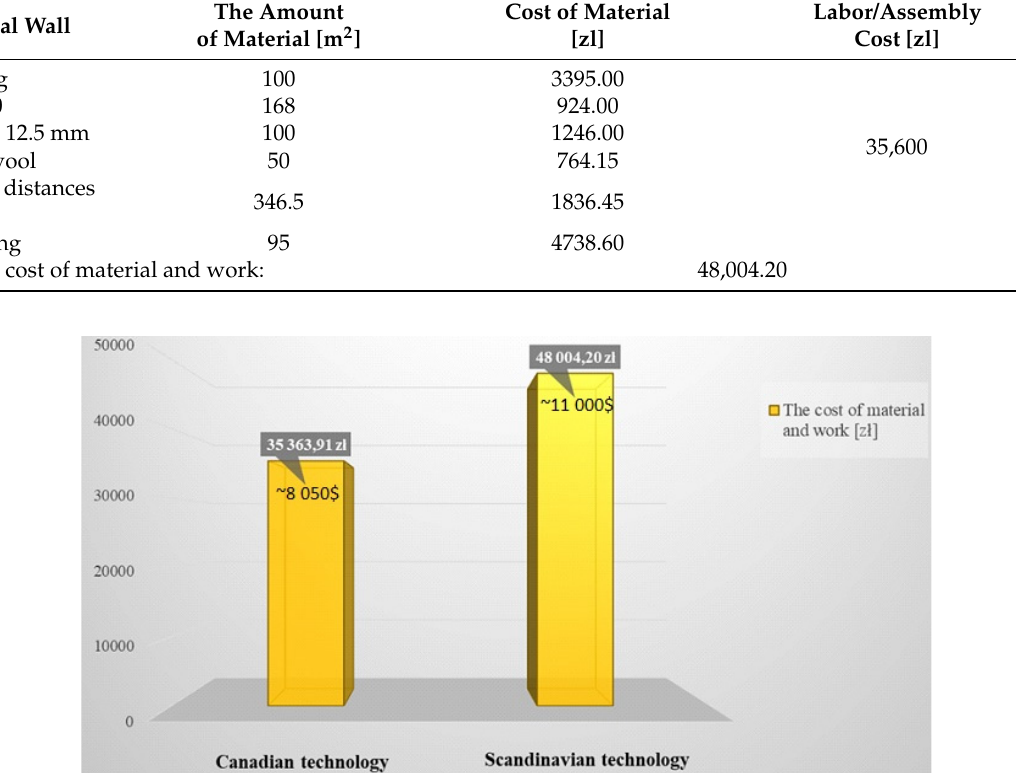
Figure 27. Comparison of the costs of finishing the exterior wall of a skeletal house using to the specified technology. Table 2. The cost of finishing external walls using Canadian technology according to the Polish prices in zlotych (PLN).